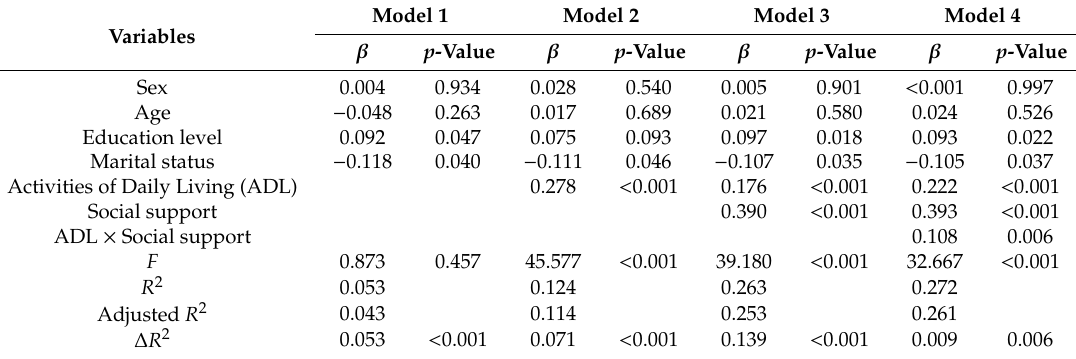
Table 5. Moderating e ff ect of social support on the relationship between ADL and life satisfaction (N =